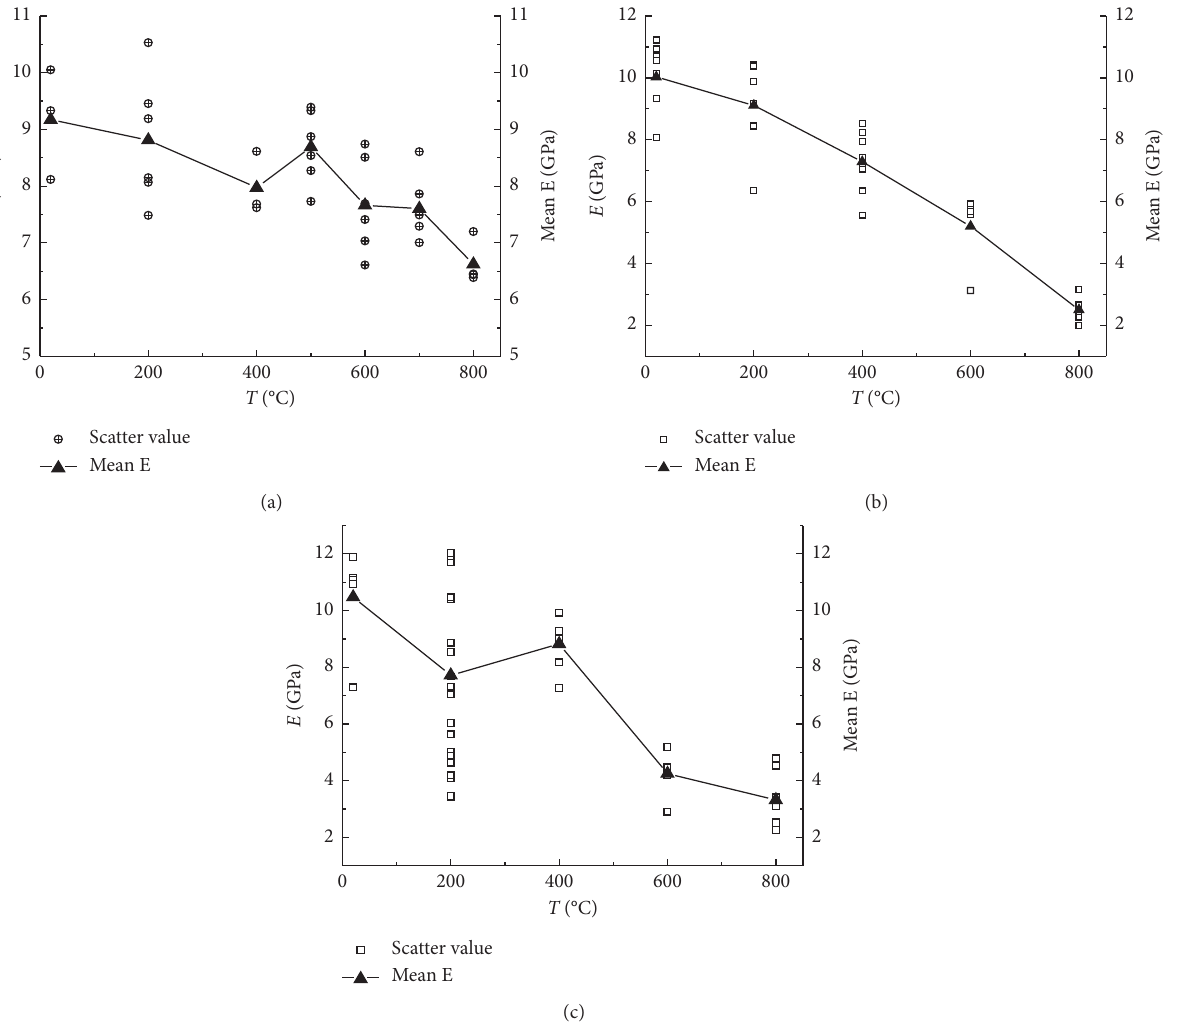
Figure 4: Change in the elastic modulus with temperature: (a) sandstone samples, (b) marble samples, and (c) granite samples.